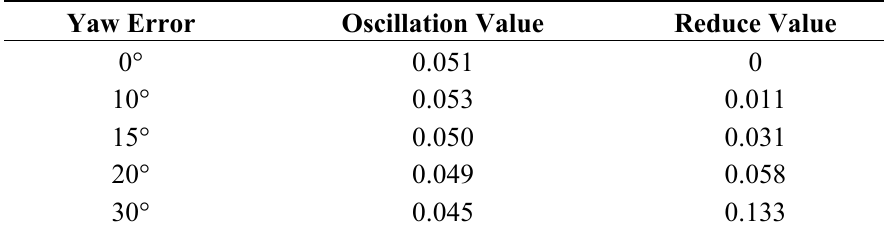
Figure 7. Effects of yaw error on S c . Table 5. Values of S c